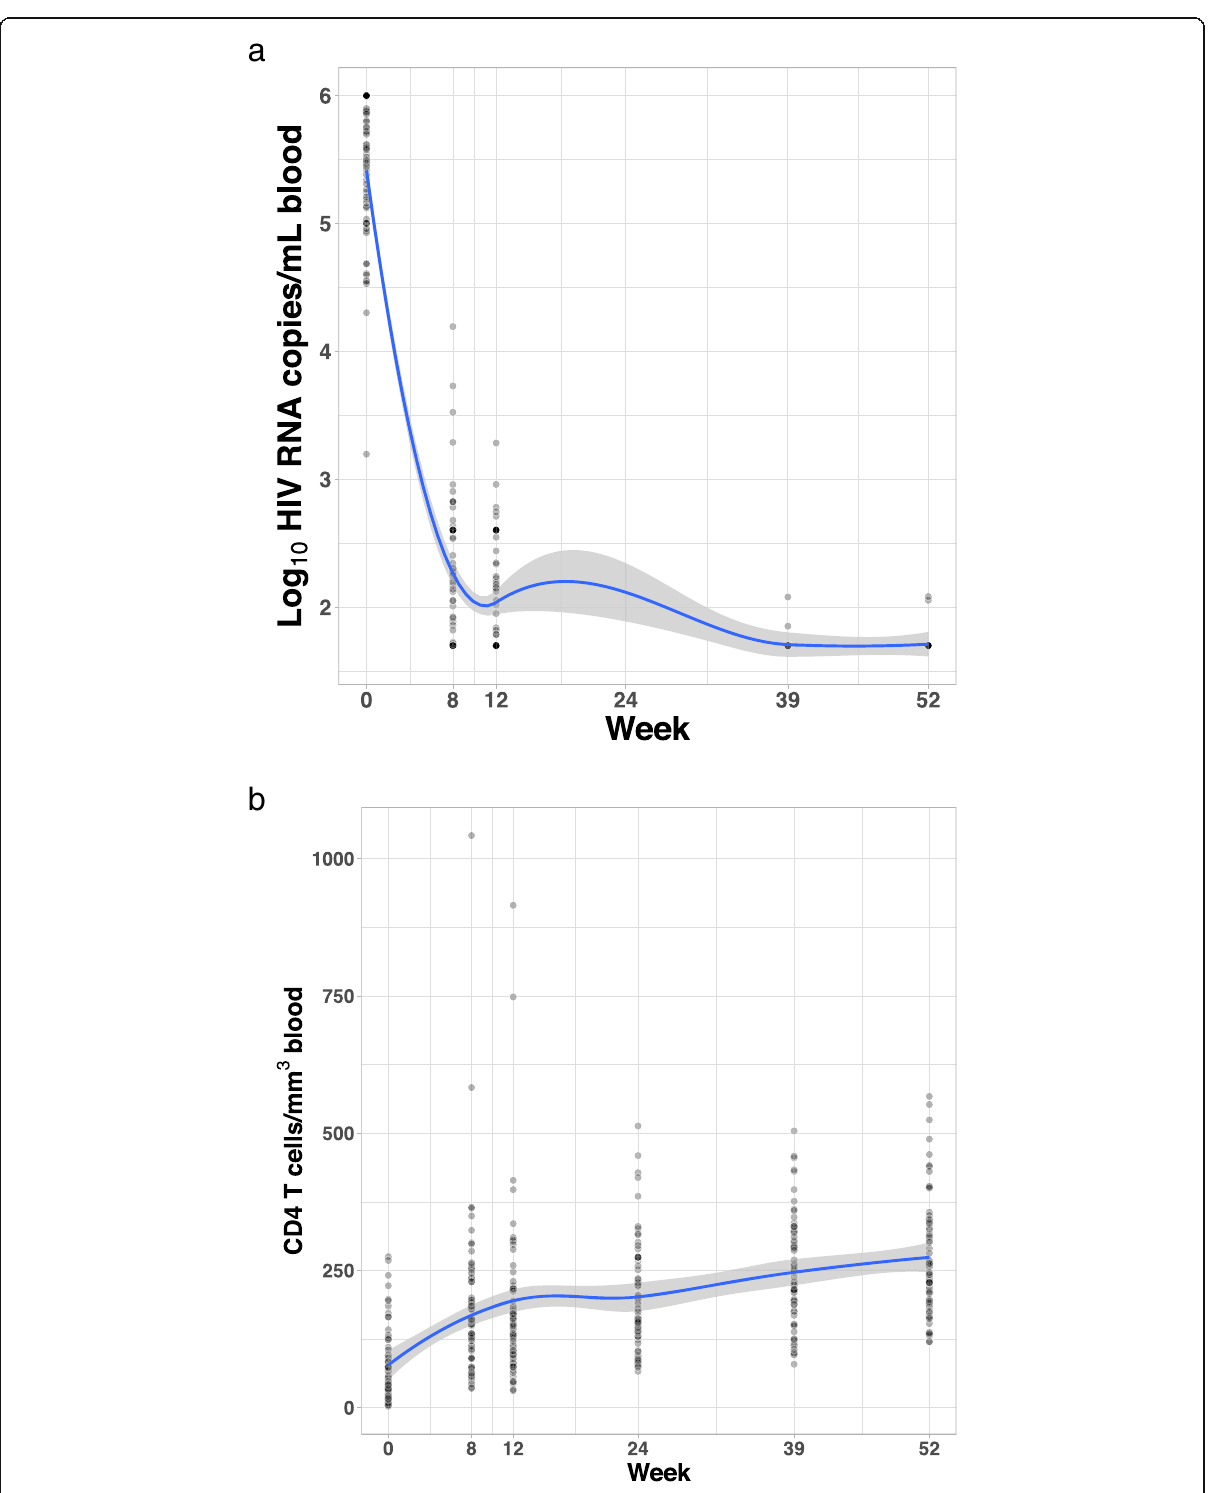
Fig. 1 Cohort ’ s response to antiretroviral treatment over one year. a , Viral load (HIV RNA copies/mL blood). b , CD4 T cell count (cells/mm 3